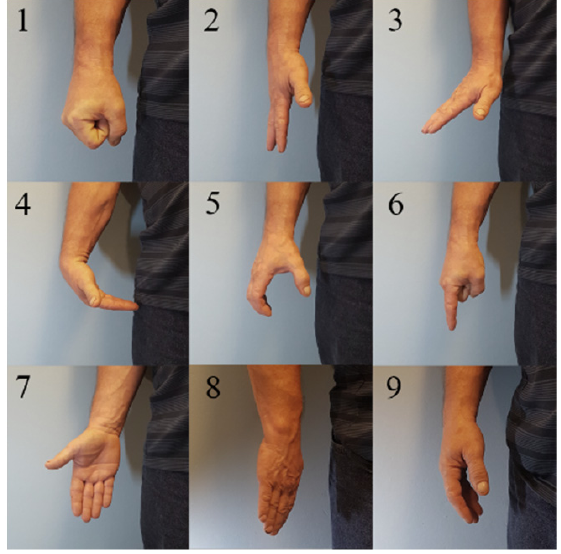
Figure 3. Gestures used in offline experiments. (1) closed hand, (2) open hand, (3) wrist extension, (4) wrist flexion, (5) chuck grip, (6) index point, (7) supination (8) pronation, and (9) rest. For the usability test, only the first four gestures, and rest, are used. The subjects are again asked to perform each motion for six seconds following a three-second countdown with six seconds’ rest between gestures, but now each gesture is performed three times. The recorded measurements are used to train an artificial neural network (ANN) for gestures classification (see Section 2.5). The subjects are then asked to complete a game in which they move a cursor to a series of square target areas on a two-dimensional grid (see Figure 2b). Both grid axes range from − 110 to +110 units, and each combination of axis and direction is associated with one of four gestures, while rest causes the cursor to remain in